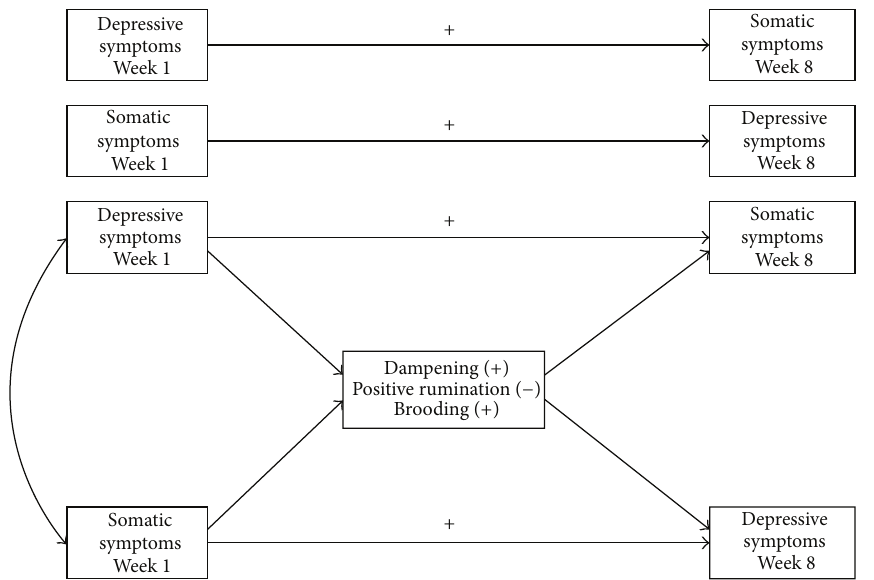
Figure 1: Theoretical model of the reciprocal relationships between depressive and somatic symptoms as mediated by dampening, positive rumination, and